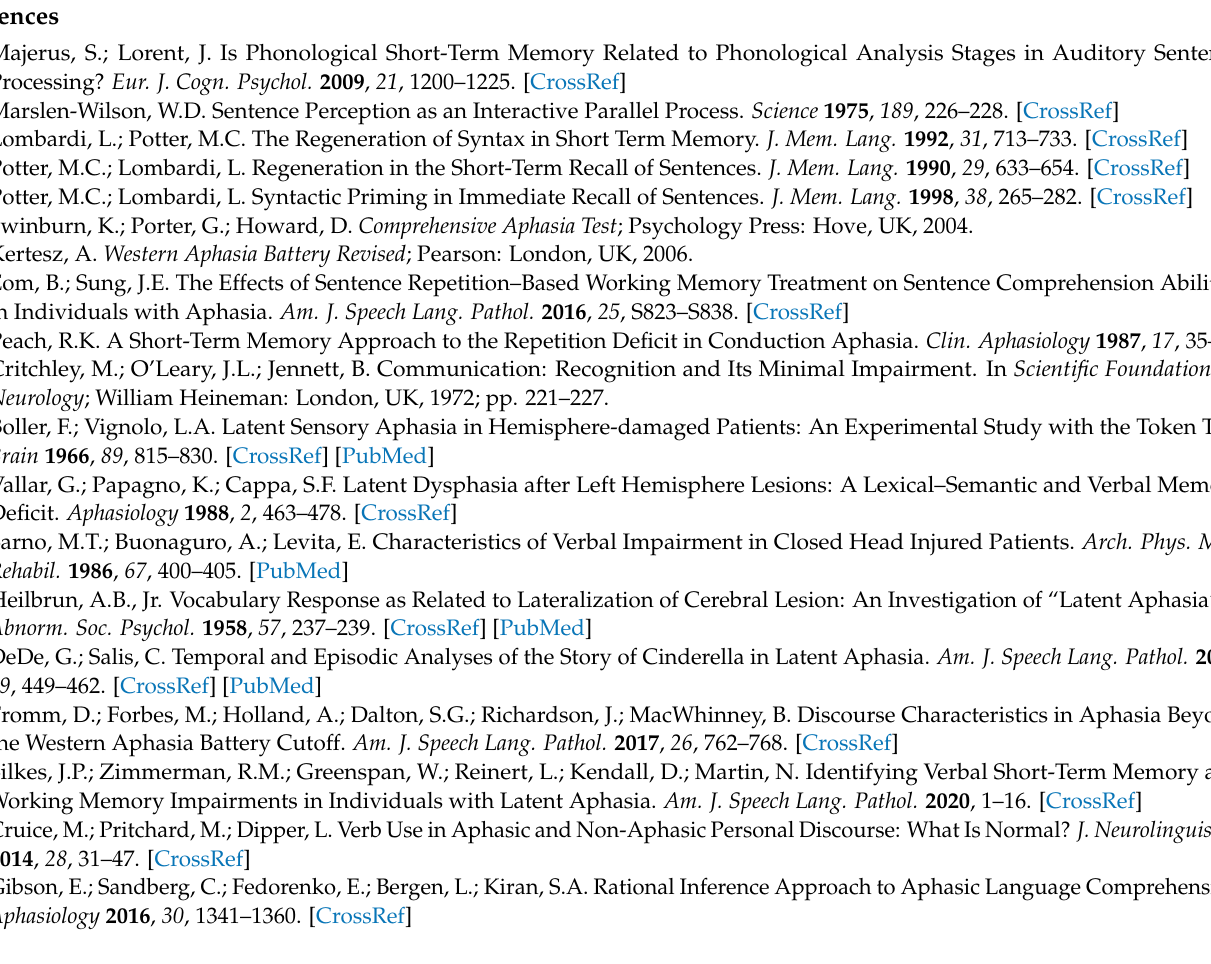
Figure A2. An example of speech